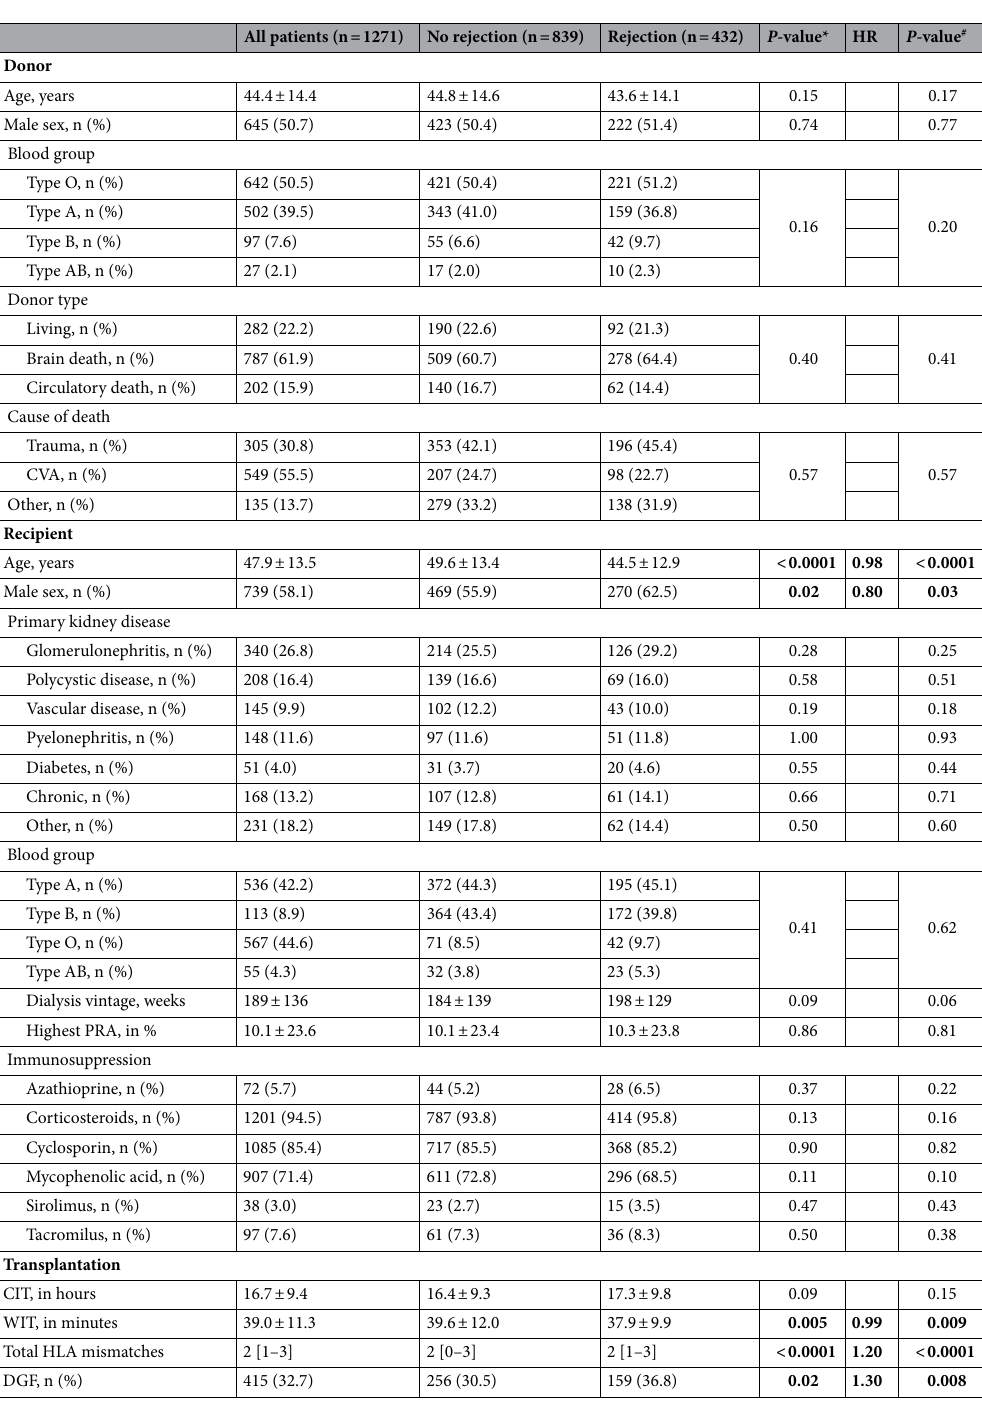
Table 1. Baseline characteristics of the donors and recipients. The clinical characteristics of all donor and recipient kidney transplant pairs as well as subgroup analysis for biopsy-proven rejection after follow-up. Data as displayed as the mean ± standard deviation for parametric variables; median [IQR] for non-parametric variables; total number of patients with percentage for nominal data [n (%)]. Bold P -values indicates P -values that are statistically significant ( P < 0.05). CVA cerebrovascular accident, CIT cold ischemia time, DGF delayed graft function, HLA human leukocyte antigen, PRA panel-reactive antibody, WIT warm ischemia time. P -value* shows the P -value for the differences in baseline demographics among the groups, tested by χ 2 test for categorical variables, and Mann–Whitney U test or Student’s t-Test for continuous variables. P -value # shows the P -value for univariable analysis for biopsy-proven